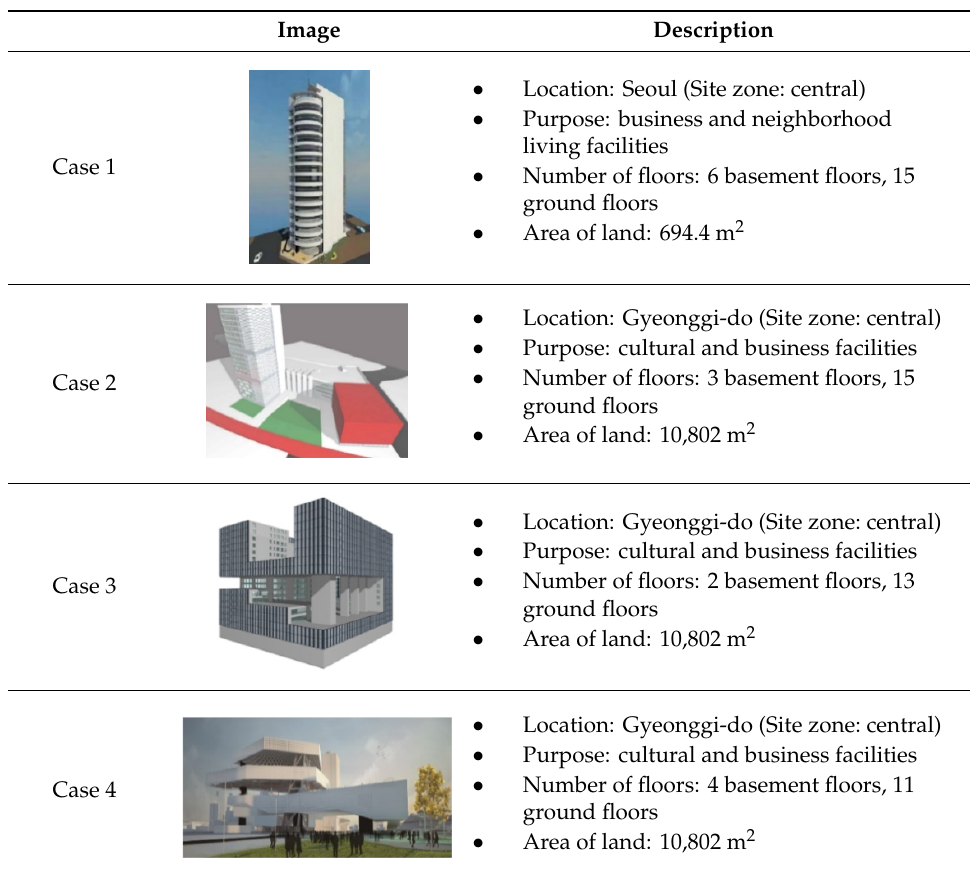
Table 8. Overview of case models.